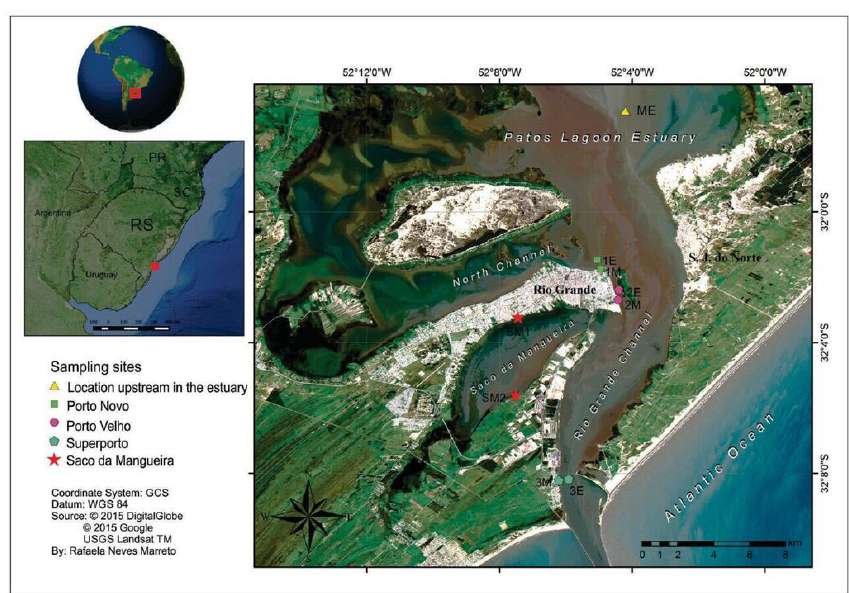
Figure 1. Sampling sites in the south of the Patos Lagoon estuary: Rio Grande Channel - margin (1M, 2M and 3M) and channel axis (1E, 2E and 3E); and Saco da Mangueira (SM1 and